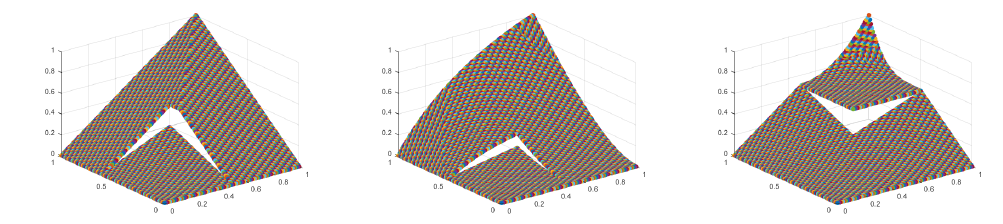
Figure 1. Pseudo-quasi overlap functions PQO